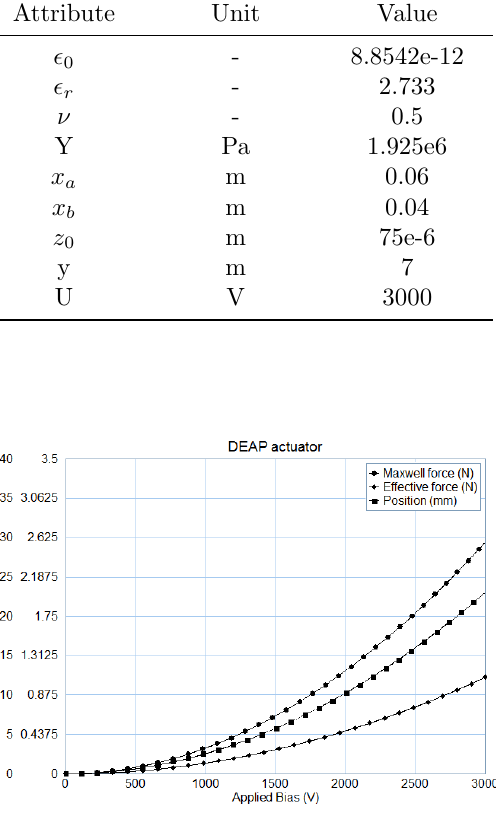
Figure 11: The actuator Maxwell and Effective Forces and Position vs. Applied voltage